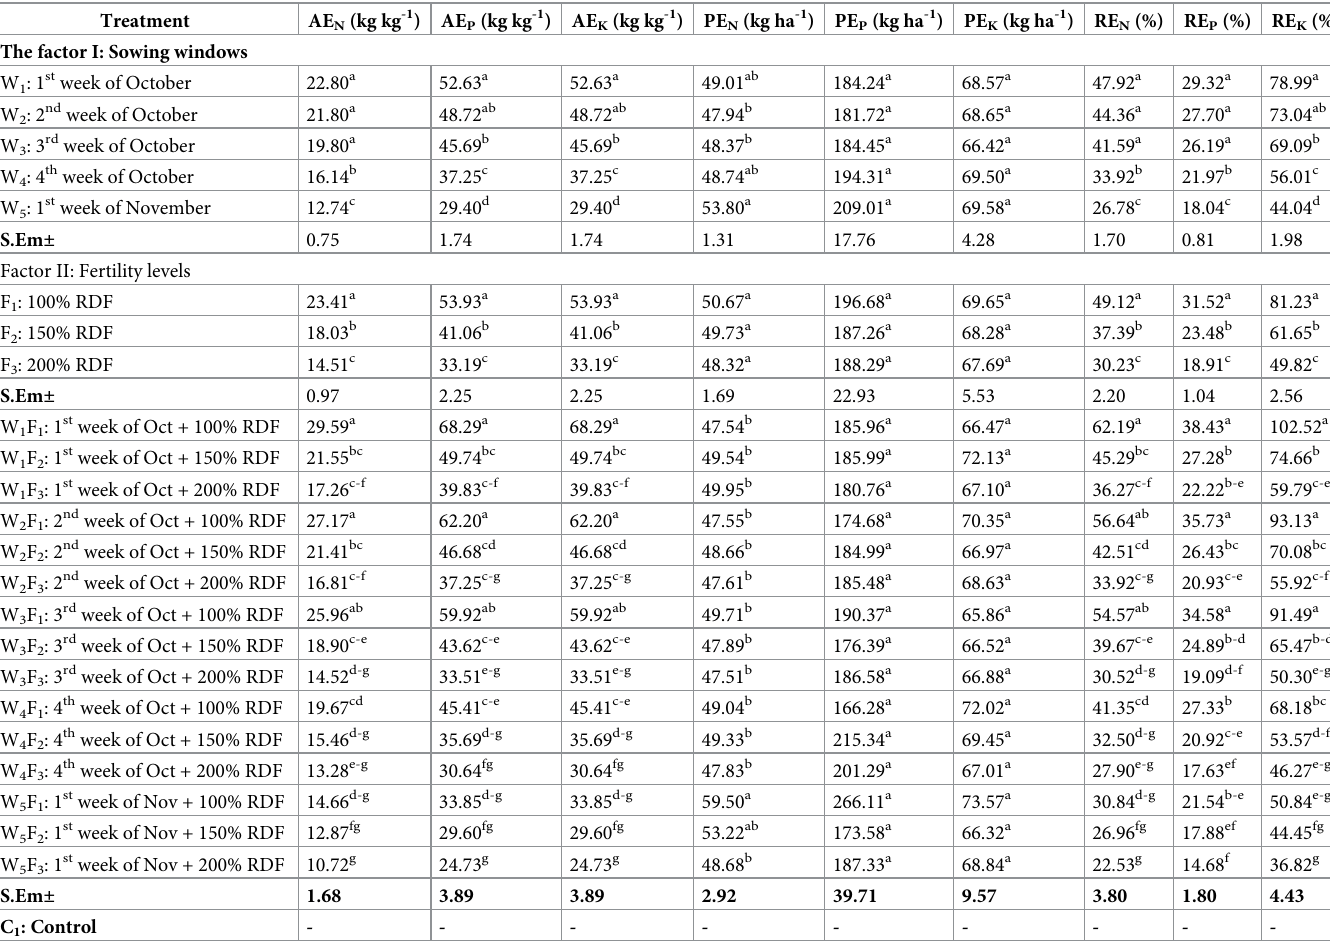
Table 4. Nutrient use efficiency of nitrogen, phosphorus, and potassium as influenced by sowing windows and fertility levels.